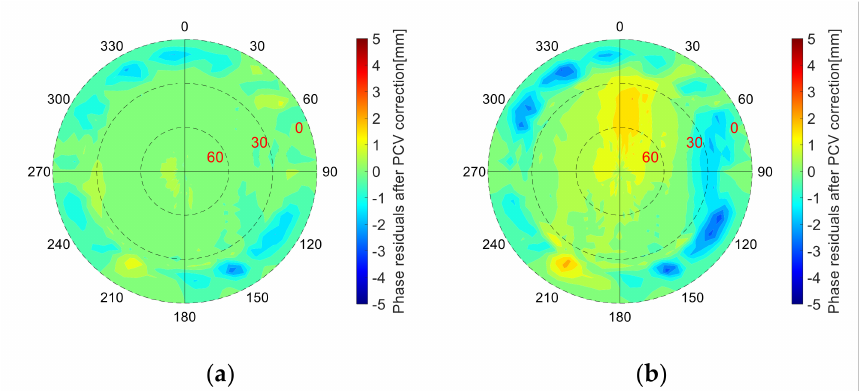
Figure 4. Carrier phase residuals of GRCC satellite derived from ( a ) DD AR solution and ( b ) SD AR solution with application of PCV